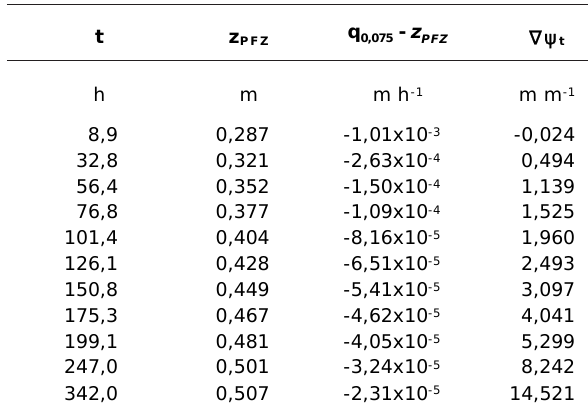
Quadro 1. Valores estimados da profundidade do plano de fluxo zero, densidade de fluxo de água e gradiente de potencial total para os tempos